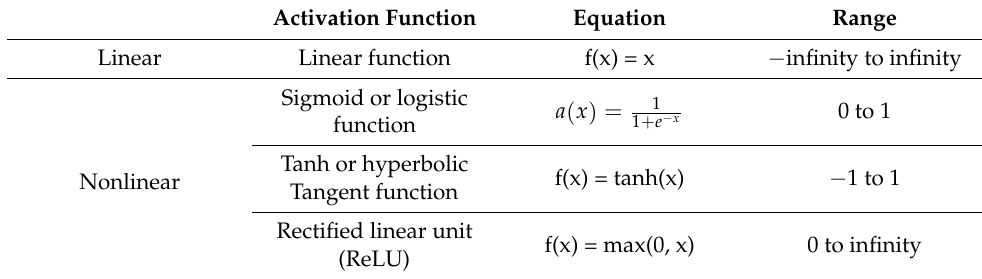
Table 6. Activation functions used in ANN [35].